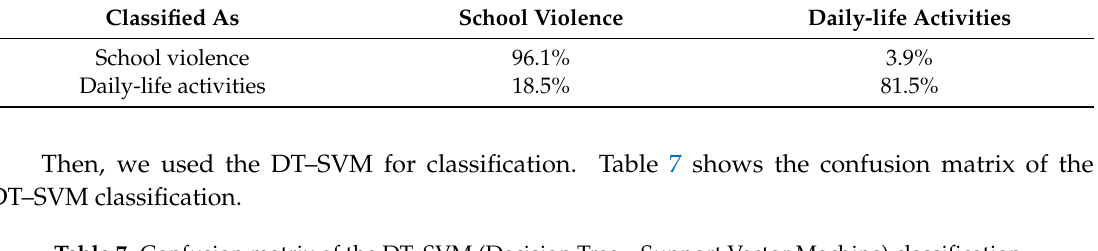
Table 7. Confusion matrix of the DT–SVM (Decision Tree – Support Vector Machine)